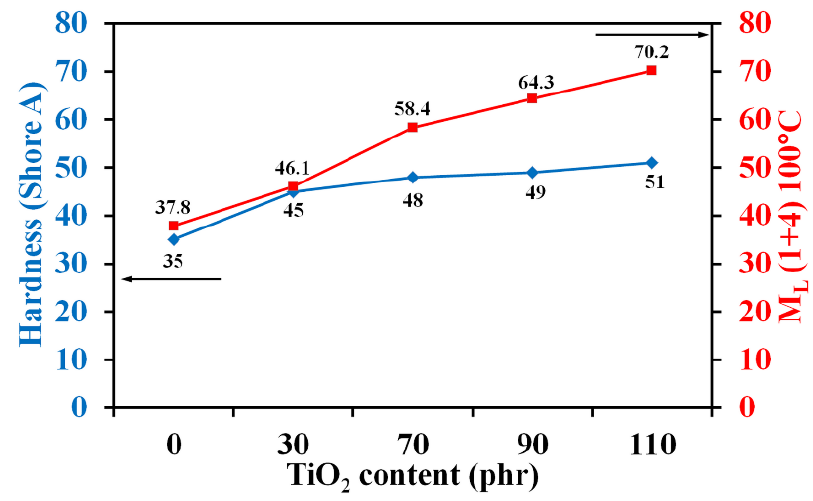
Figure 2. Mooney viscosity and hardness of TiO 2 -filled NBR composites with various TiO 2 loadings. The torque difference ( M H − M L ) indirectly reflects the crosslink density in rubber vulcanizates. M H − M L increased with the addition of TiO 2 indicating a higher crosslink density caused by TiO 2 due to strong filler–rubber interactions: the physical interactions between polar -C ≡ N groups in NBR and –OH groups on TiO 2 surfaces. These surface